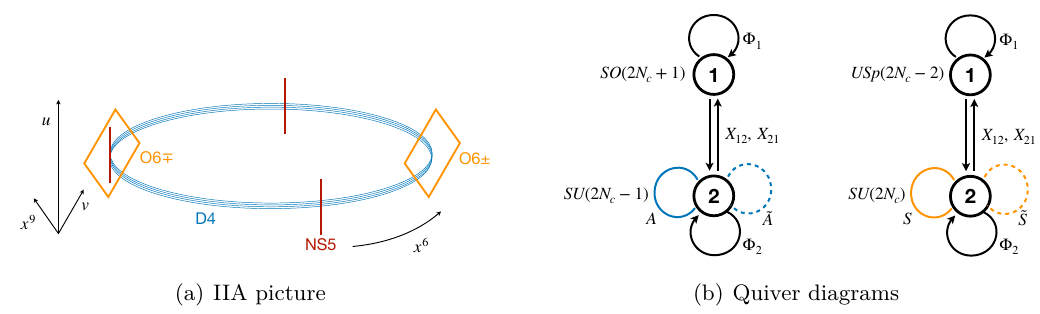
Figure 8 . N = 2 S-dual quivers with n g = 1